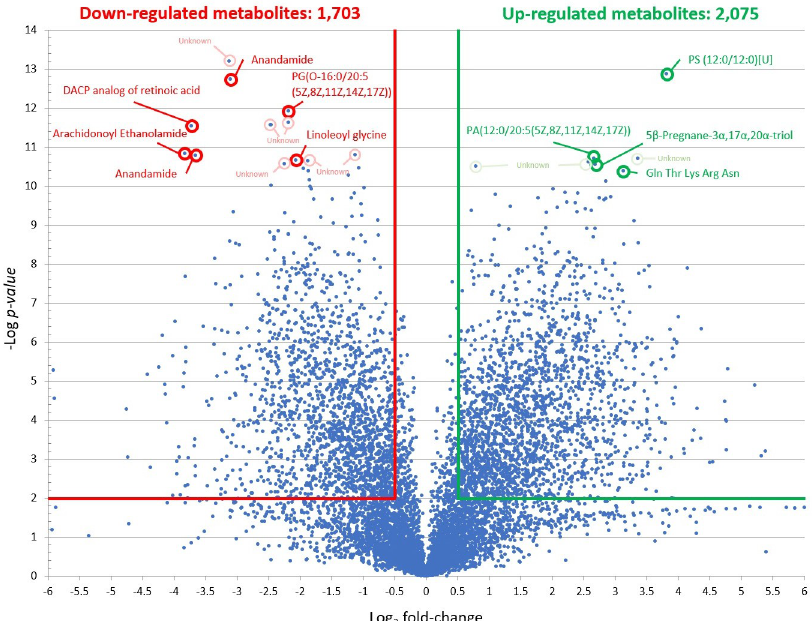
Fig 4. Volcano plots showing differentially expressed metabolites of S . mekongi following high-dose PZQ treatment. Horizontal green and red lines represent p- values equal to 0.01. Vertical green and red lines represent fold changes equal to 1.5 and − 1.5, respectively. Top 10 metabolites with the lowest p -values (highly significant) and largest fold changes of each dose were labeled. Green and red refer to higher and lower abundance of metabolites,